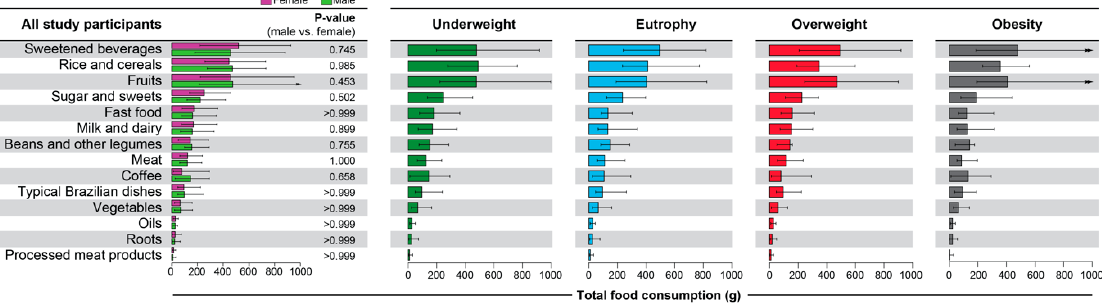
Figure 3. Consumption of food groups in individuals according to gender and anthropometric status. Data represent median and interquartile range of total consumption of each food group in grams. Left panel: For each food group, data were compared between males and females using the Mann-Whitney U test. Right panel: Distribution of the data in the groups of individuals with different anthropometric states.